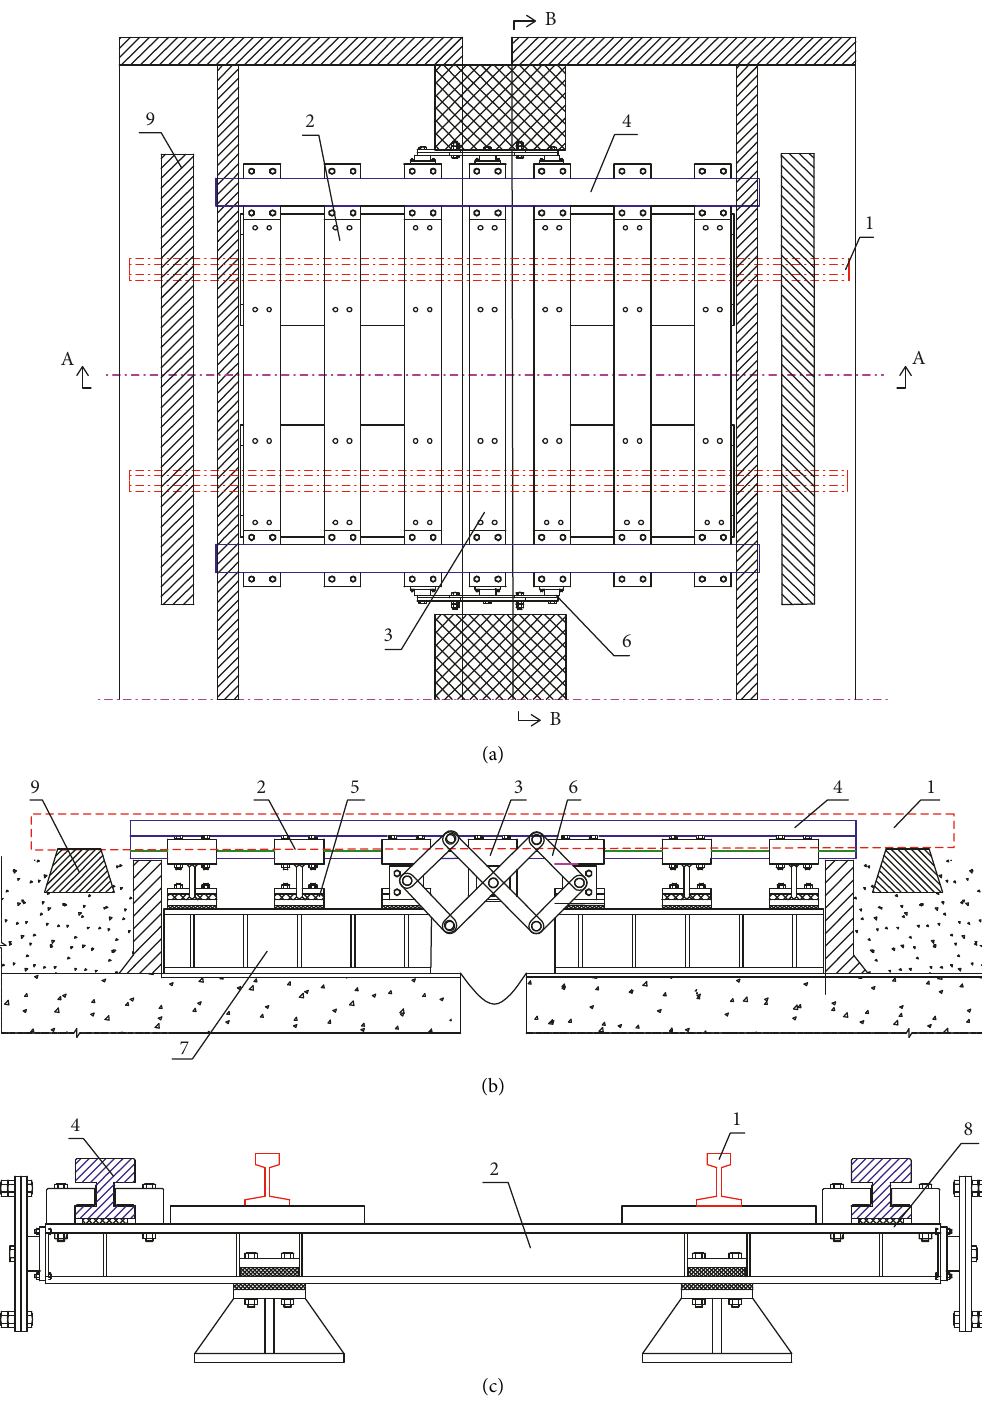
Figure 3: The structure of BEJs: (a) top view. (b) A-A section. (c) B-B